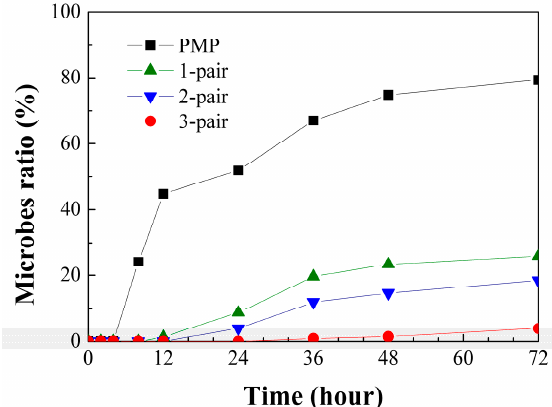
Figure 4. Ratio of microbe adhesion area to sample area for PMP without and with different pairs of SiO x /SiC x H y stacked films as a function of time.